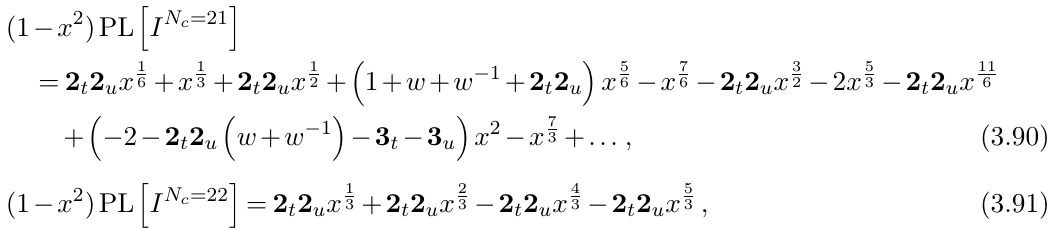
2 x 3 2 − 2 x 5 3 − 2 t u